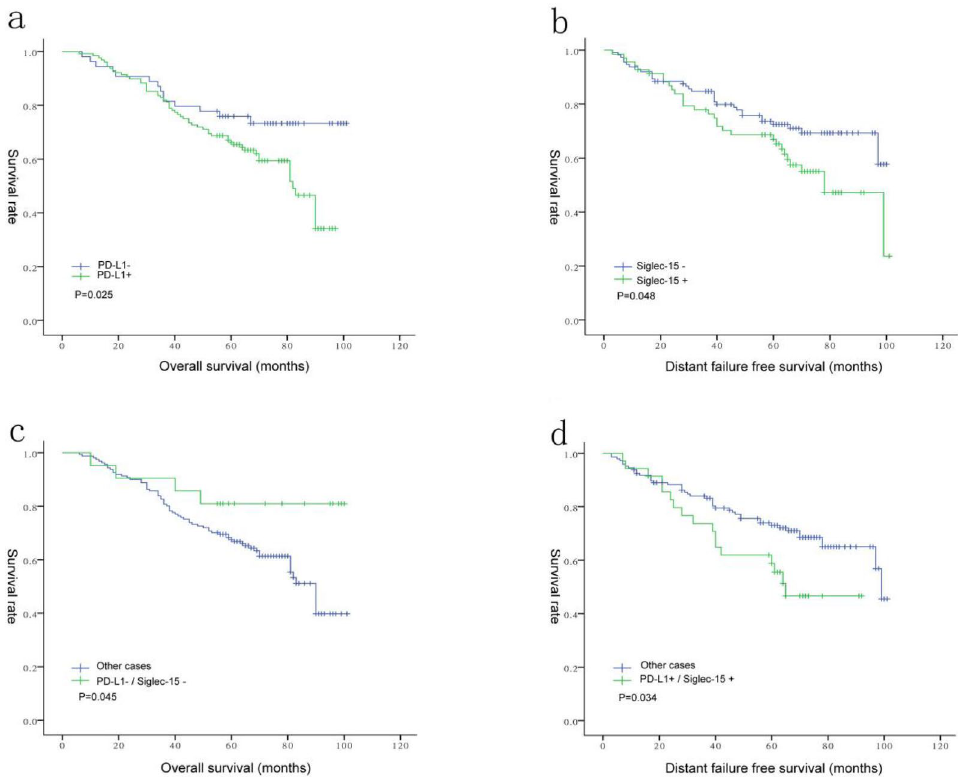
Figure 2. ( a ) Correlation between PD-L1 expression and overall survival (OS); ( b ) correlation between Siglec-15 expression and D-FFS; ( c ) correlation between PD-L1 and Siglec-15 expression and OS; ( d ) correlation between PD-L1 and Siglec-15 expression and